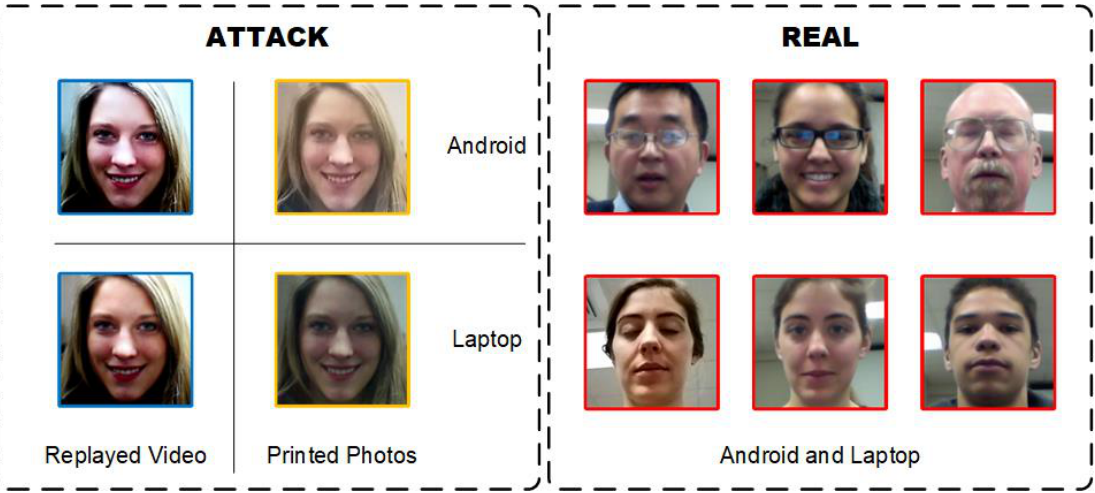
Figure 7. The images depicted above present a collection of misclassified samples obtained from the O&C&I to M task protocol. The left-hand box displays misclassified attack faces, which were all sourced from a single individual whose attack samples were across two types, and all collection methods were misclassified. In contrast, the right-hand box shows some misclassified real face samples, which originated from videos captured via an Android or laptop